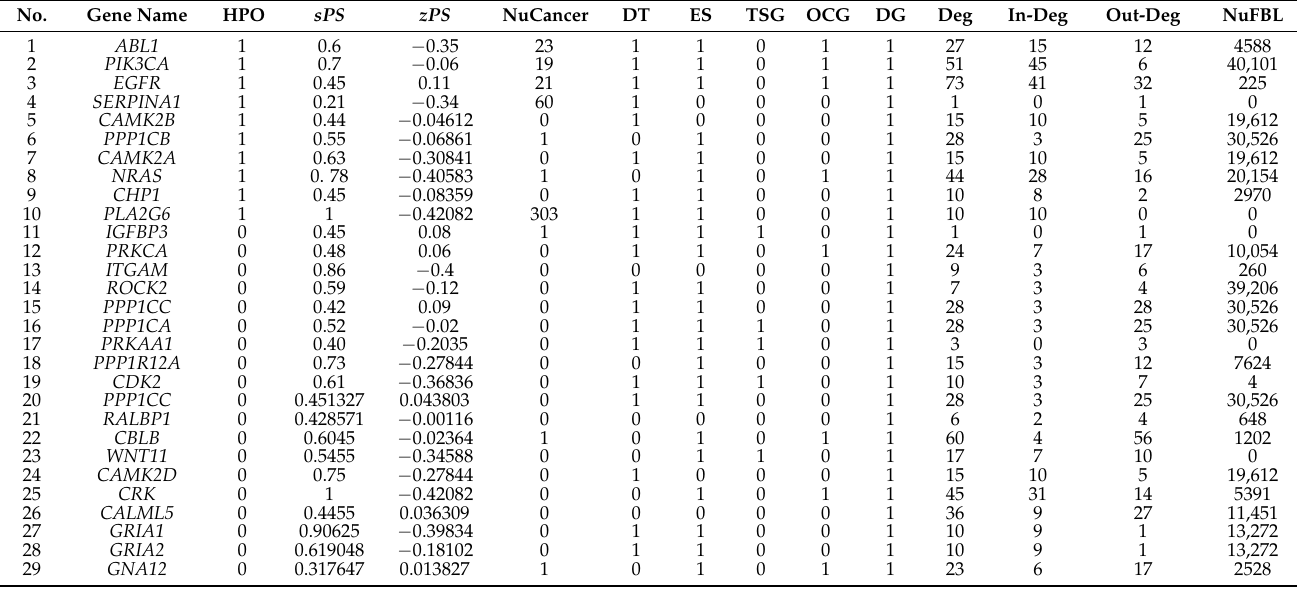
Table 2. Significant pleiotropic genes in KEGG network.